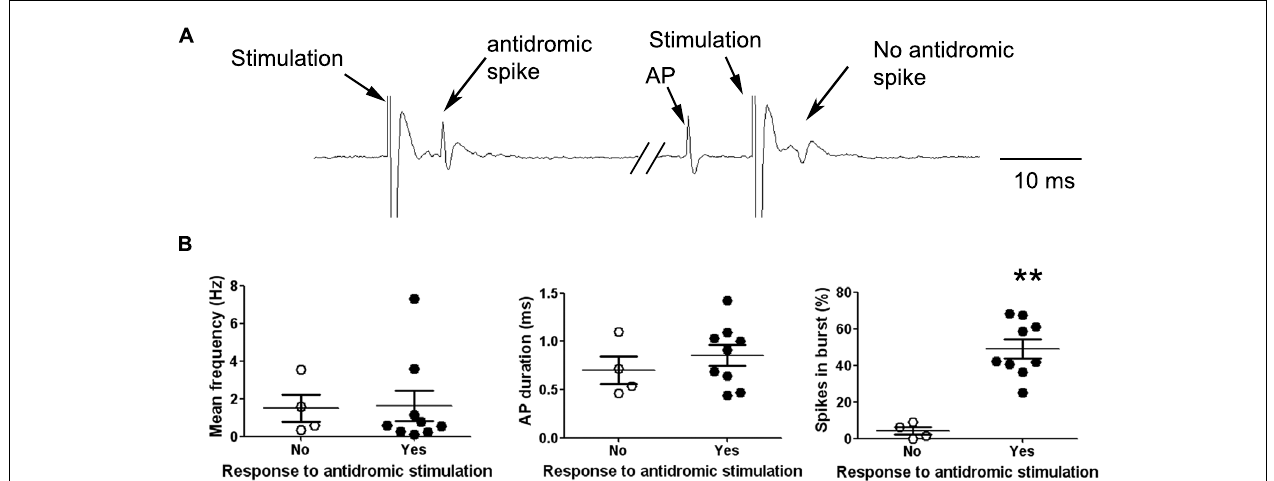
response after the stimulation (right). (B) Neurons were divided in two groups according to their response (black dots) or not (white dots) to the striatal stimulation, the graphs show the individual data (large dots) as well as the mean ± SEM of electrophysiological characteristics: Mean frequency (Hz), AP duration (ms) and percentage of spikes included in a burst (%). ** p < 0.01.